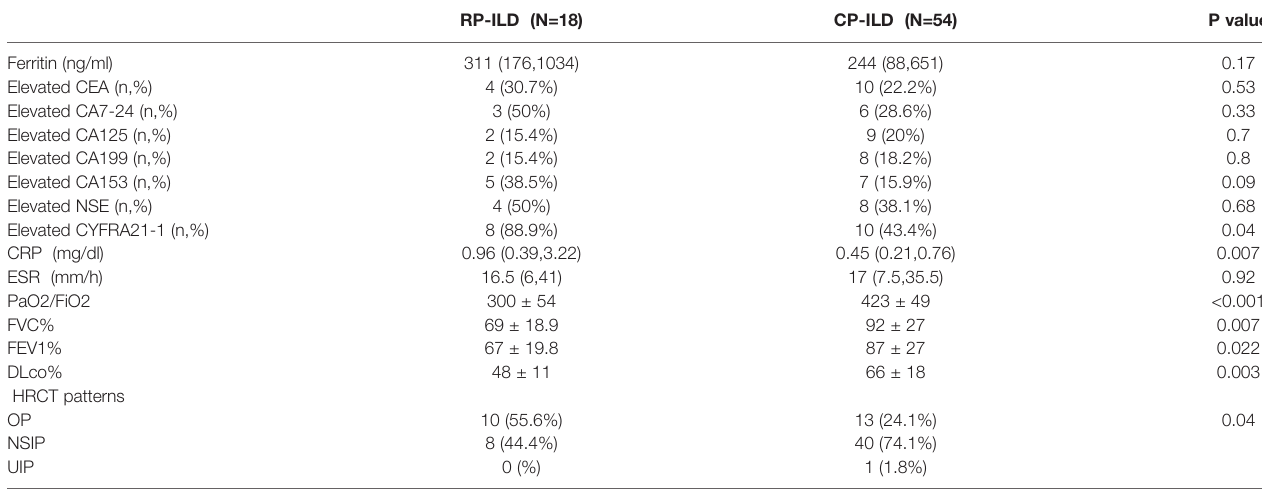
(Table2Breakdown):ContinuousdatawerepresentedasM (mean)±SEM (standarderrorofthemean),ormedians (interquartilerange).Binarydatawerepresentedasn (%)ofthepatients. DM, dermatomyositis; CADM, Clinical amyopathic dermatomyositis; JDM, Juvenile dermatomyositis; CK, creatine kinase; LDH, Lactate Dehydrogenase; FVC, Forced Vital Capacity; FEV1,